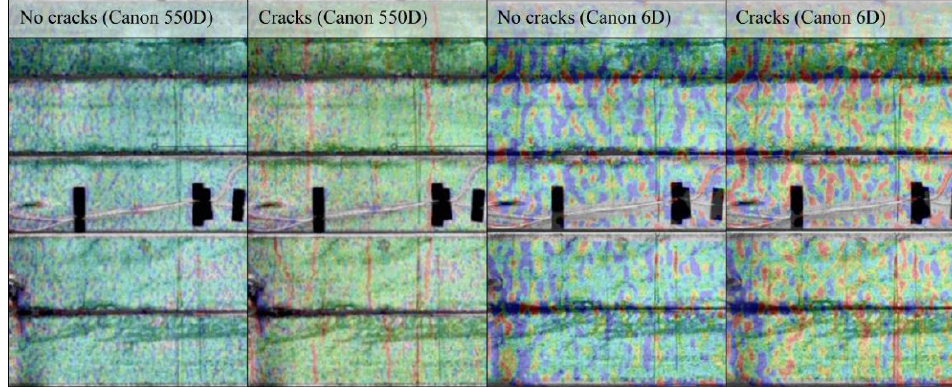
Figure 18. Crack Detection for Strip 2. All with Subset 30/10.